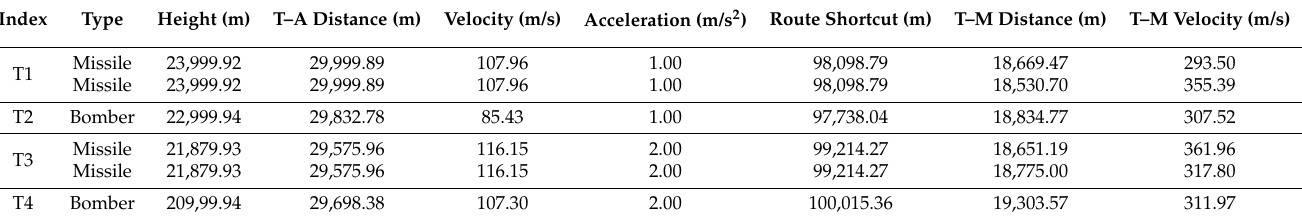
Table 2. The index values with respect to the targets.